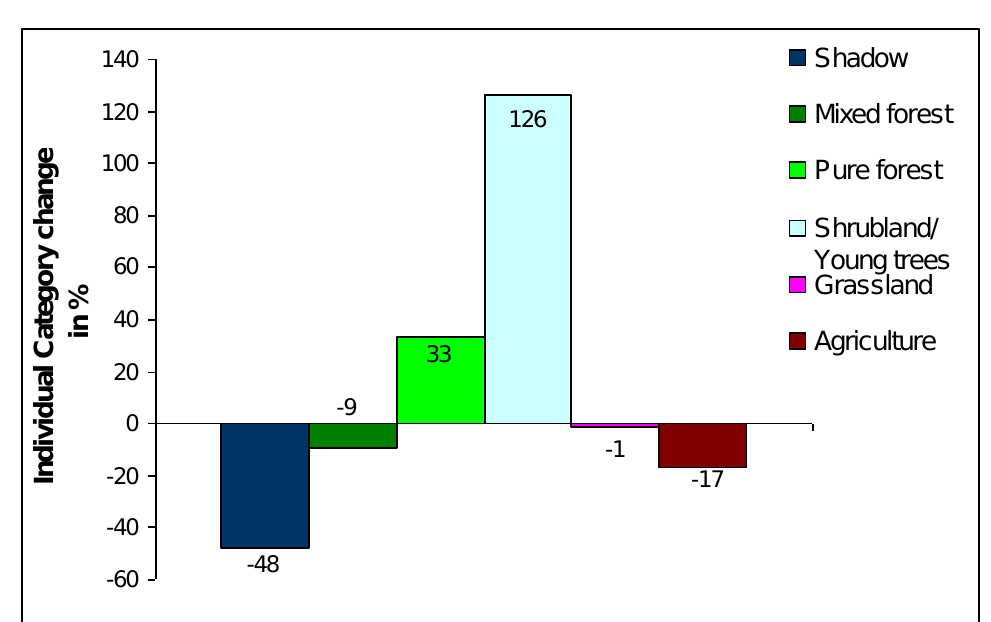
Figure 4. Trend (gain or loss) of the land